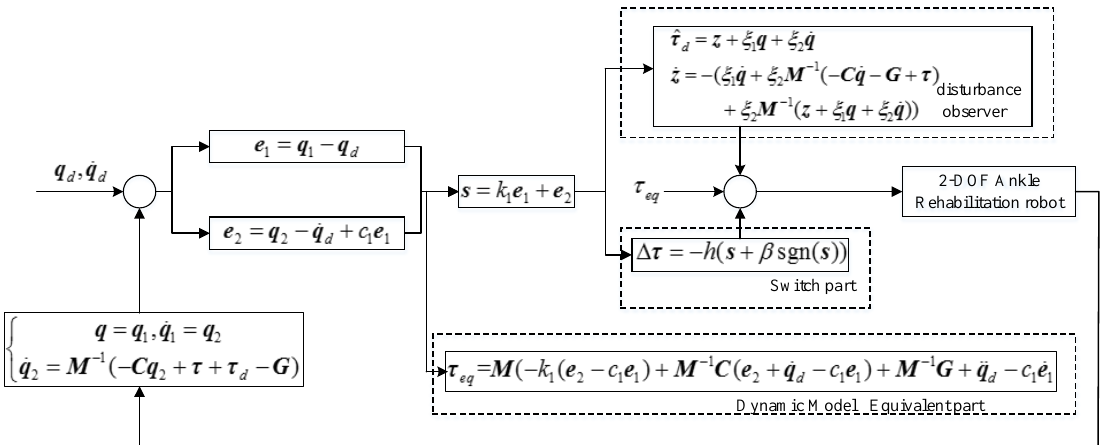
Figure 4. Implementation of ABS-SMC for the ankle rehabilitation